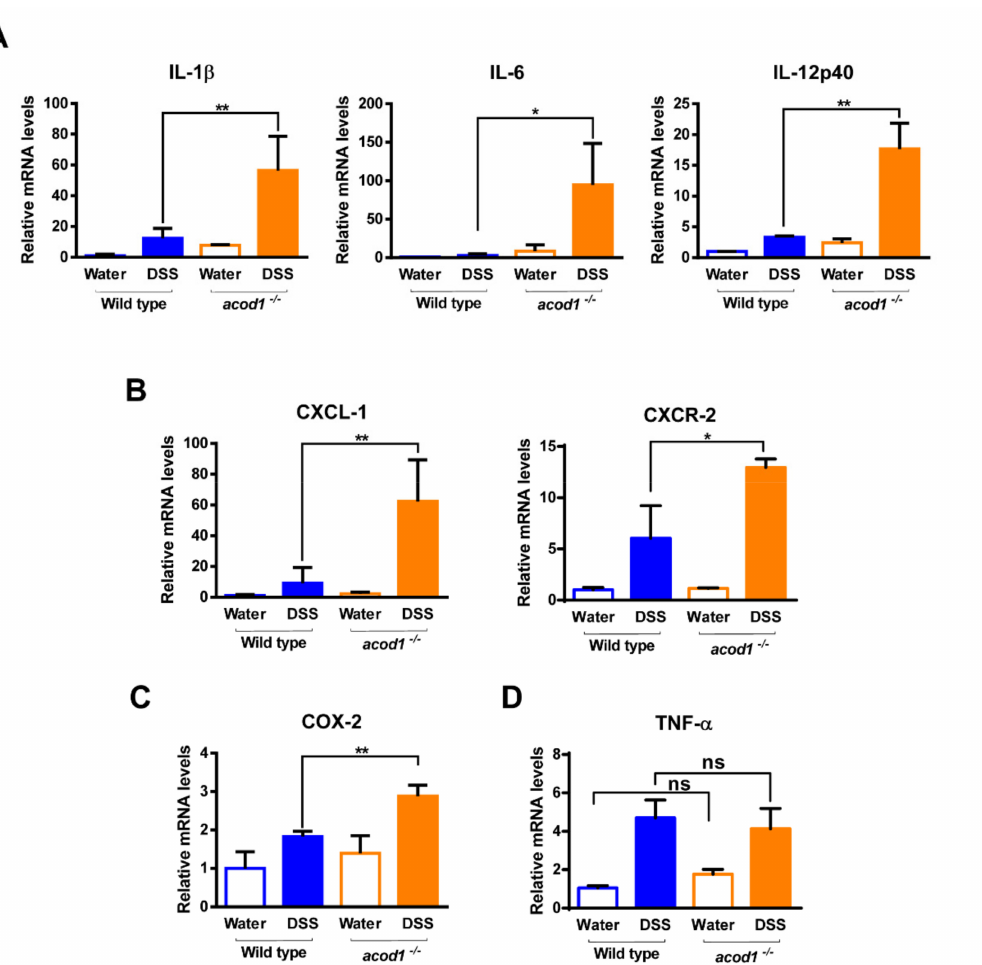
Figure 3. Acod1 gene deficiency induces inflammatory cytokine, the inflammatory mediator, and chemokine expression in DSS-induced colitis. The mRNA levels of IL-1 β , IL-6, and IL-12p40 ( A ); CXCL-1, CXCR-2 ( B ), COX-2 ( C ); and TNF- α ( D ) in the colonic tissues were determined by quan- titative real time-PCR. Expression was normalized to that of β -actin, and each bar represents the mean ± SD. Symbols * and ** denote p < 0.05 and p < 0.01,